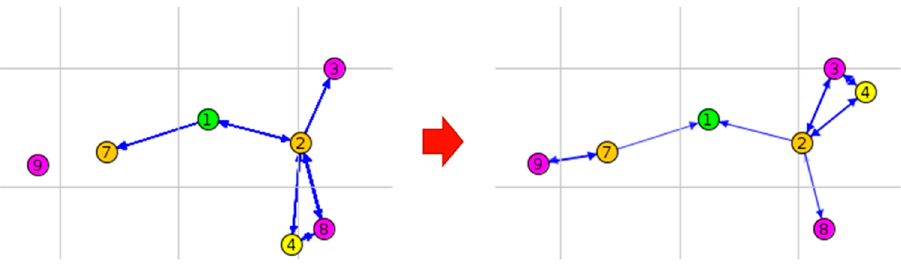
Figure 20. Simulation for the VT handover.